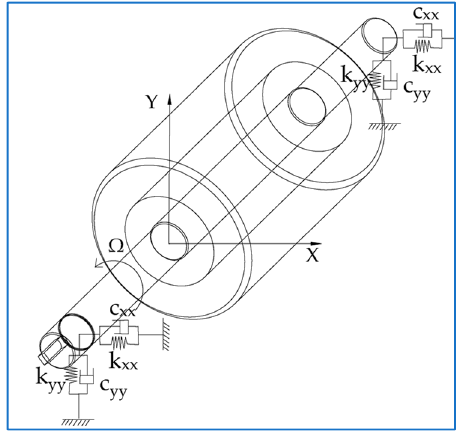
Figure 2. The dynamic model of roll coating rotor components.